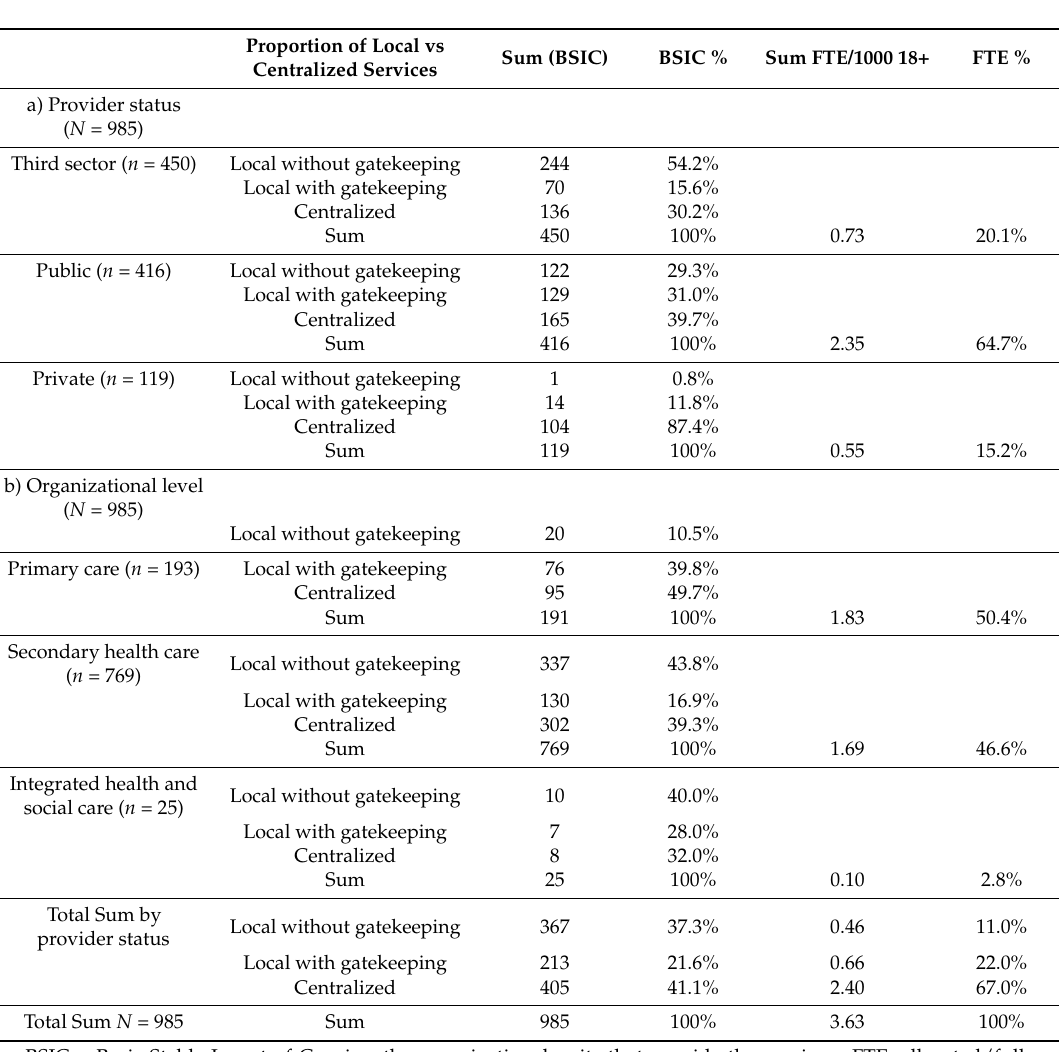
Table 4. The proportion of local vs. centralized services by provider status (a) and vertical level of organization (b) ( N =